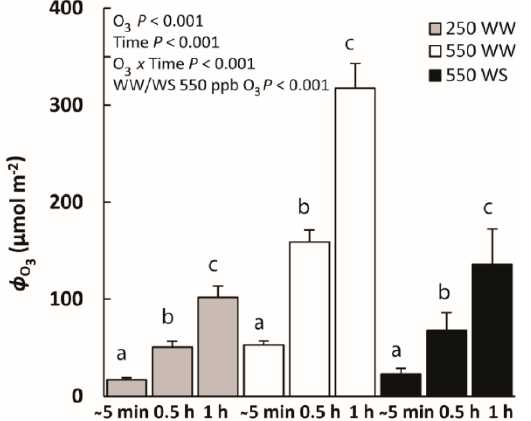
Figure 1. Total O 3 uptake ( Φ O3 , mean ± SE) in well-watered (WW) plants and water-stressed (WS) Brassica nigra plants during the O 3 treatments of 250 or 550 ppb measured at the beginning (~5 min), in the middle (0.5 h) and at the end (1 h) of the fumigation. Grey bars correspond to WW plants treated with 250 ppb, white bars correspond to WW plants treated with 550 ppb and black bars correspond to WS plants treated with 550 ppb. Data between different time-points within treatments were compared by paired sample t -tests and significant differences ( p < 0.05) are shown by lowercase letters. The effects of exposed O 3 , recovery time and their interaction and the effect of water stress (WS vs. WW) in plants treated with 550 ppb were evaluated by repeated measures